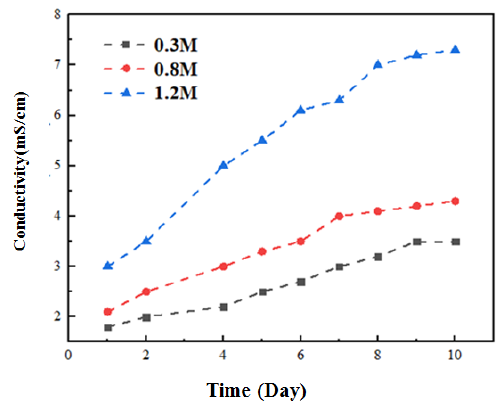
Figure 3. Change in anolyte conductivity during operation of OsMFC.